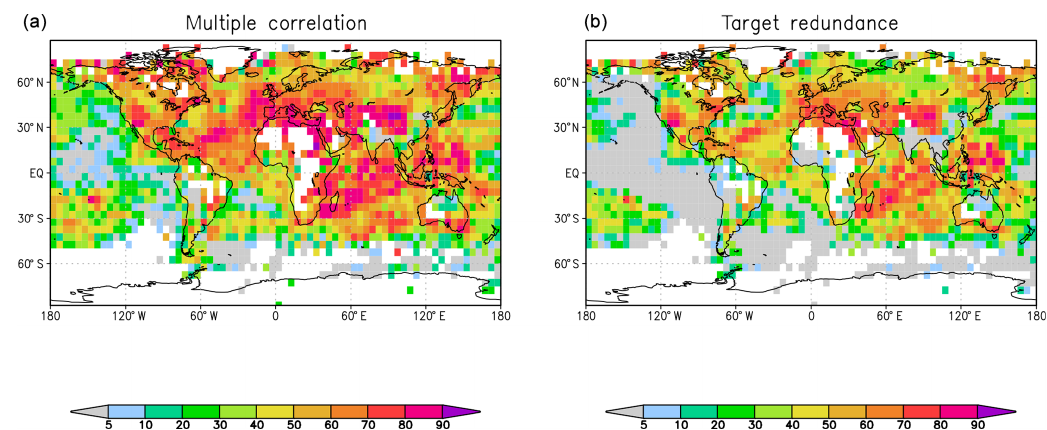
Figure 1. Squared multiple correlation coefficients (a) and target redundances (b) between 2m temperature from HadCRUT4 observations and two MiKlip ensemble forecasts, namely the ensemble Kalman filter (EnKF) and pre-operational version (PREOP), for lead years 2 to 5. Units are a fraction of the explained variance in the observations in percentages. Assuming a Student t distribution of the R 2 estimates, and about 13 degrees of freedom, the confidence intervals R 2 (in percentages) are 14 < 60 < 85, 26 < 70 < 90, and 45 < 80 < 94.